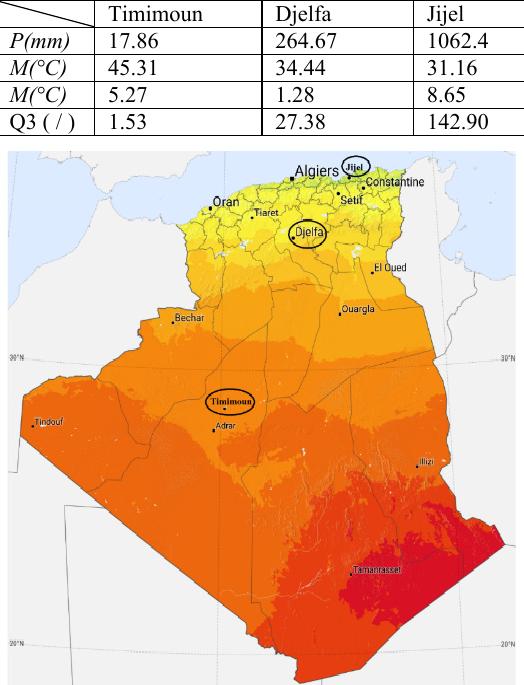
Table 2. Emberger rainfall quotient in three regions.